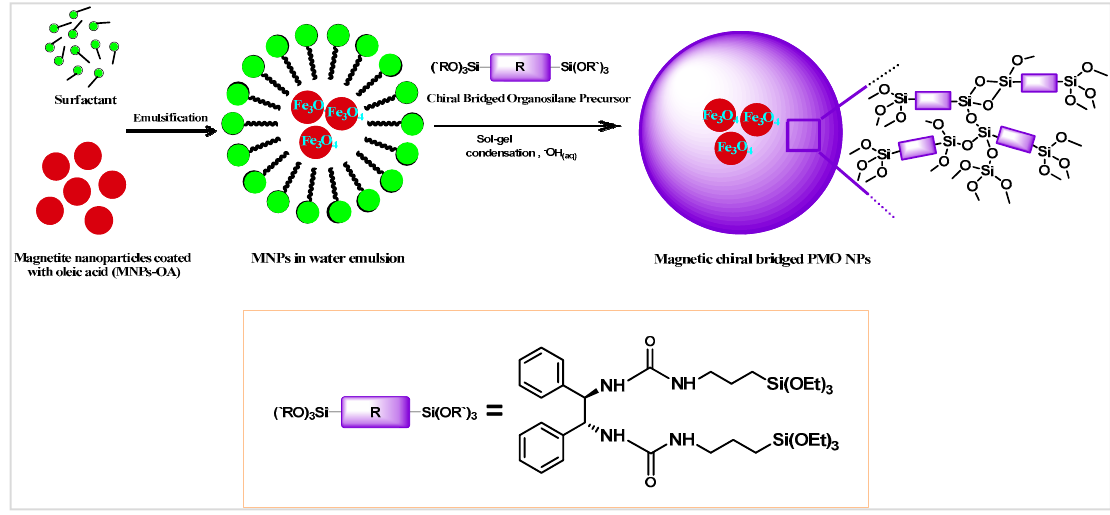
Scheme 2. Preparation of magnetic chiral PMO nanoparticles.